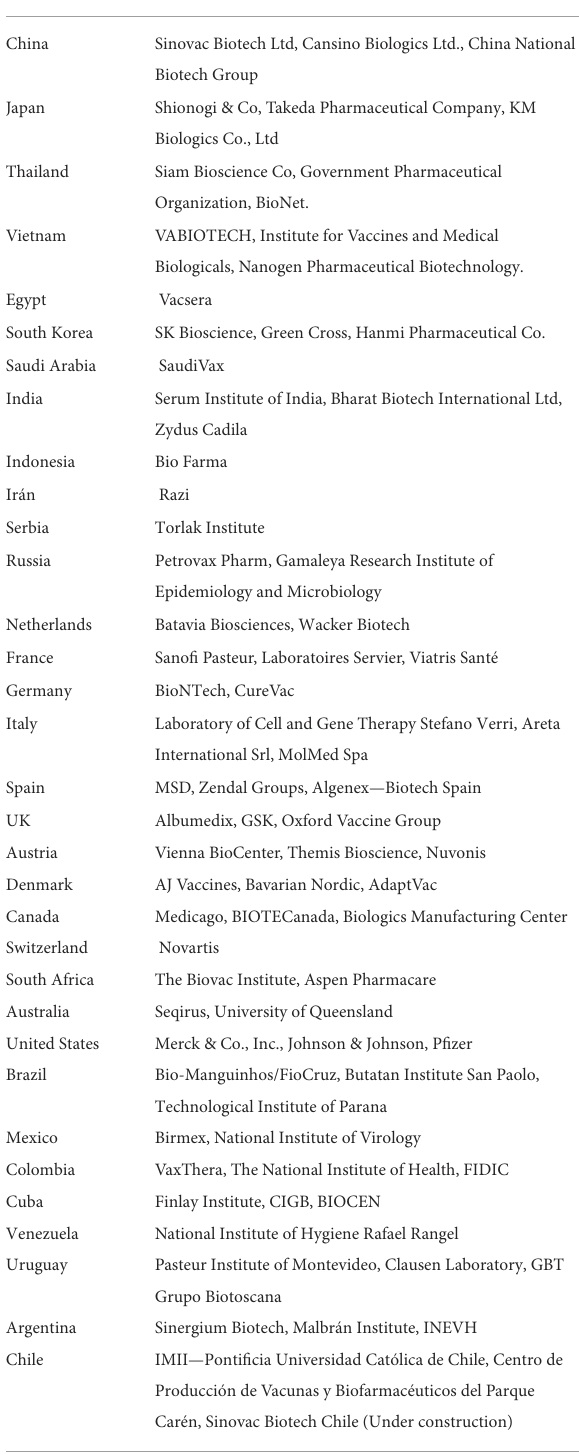
TABLE 2 List of leading GMP manufacturing facilities worldwide (41–104).